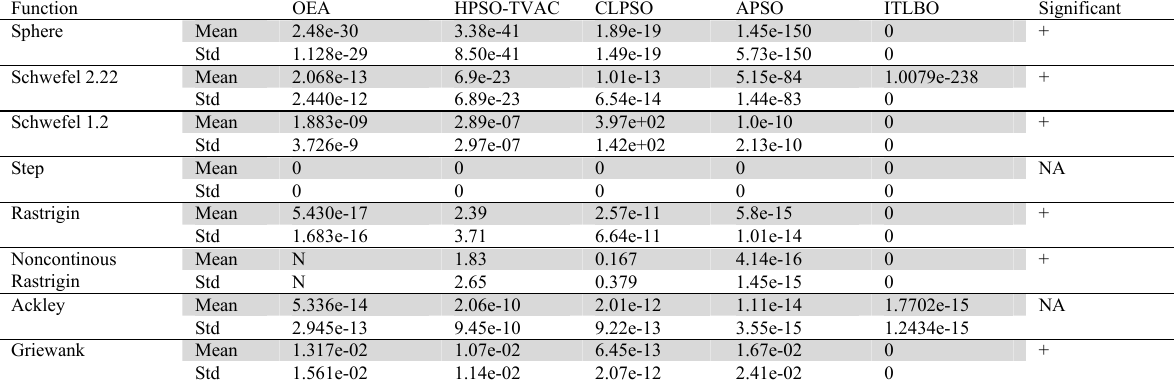
Performance comparison for ITLBO,OEA,HPSO-TVAC,CLPSO and APSO Function OEA HPSO-TVAC CLPSO APSO ITLBO Significant Sphere